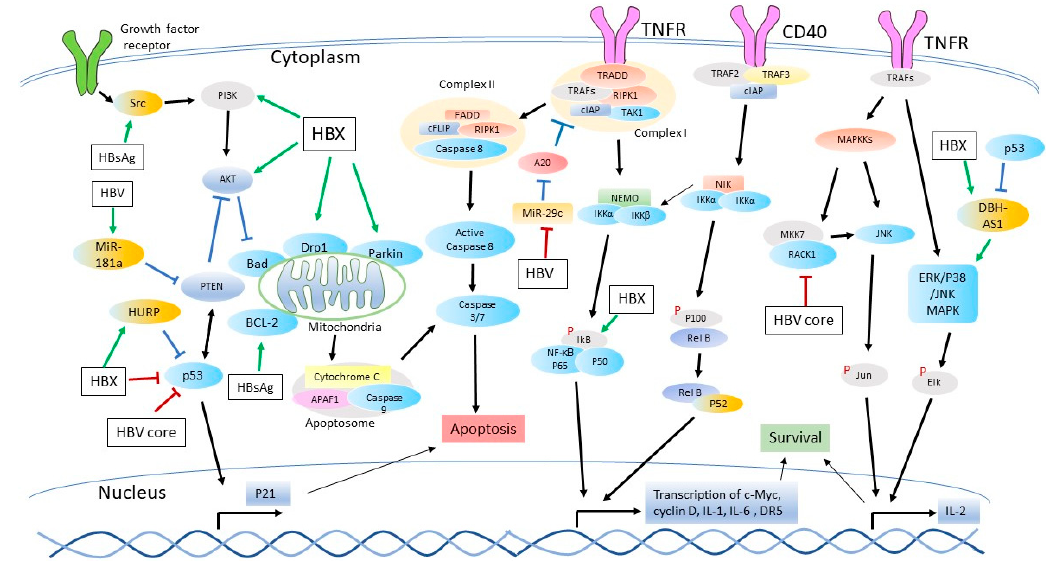
Figure 1. Inhibition of apoptosis by hepatitis B Virus (HBV) infection. Hepatitis B Virus X protein (HBX) and HBV core inhibit p53-mediated apoptosis. HBX activates the phosphatidylinositol-4,5-bisphosphate 3-kinase-protein kinase B (PI3K-Akt) pathway to inhibit apoptosis via the upregulation of PI3K and the induction of Akt phosphorylation. HBX inhibits the intrinsic apoptotic pathway by recruitment of Drp-1 and Parkin to the mitochondria for mitochondrial fission and mitophagy. The activation of Akt also prevents translocation of BAD to the mitochondria, thereby preventing apoptosis. HBX can activate the nuclear factor kappa-light-chain-enhancer of activated B cells (NF- κ B) signaling via the degradation of I κ B. In the MAPK-JNK pathway, HBV can attenuate the function of the kinase that activates JNK. HBV can downregulate apoptosis by either elevation of anti-apoptotic ncRNAs such as MiR-181a, or decrease of pro-apoptotic ncRNAs, such as MiR-29c. Green arrows next to the white boxes (HBV or HBV proteins) denote the activation of apoptosis. Red bars to the white boxes stand for the inhibition of apoptosis. Drp-1: Dynamin-1-like protein. BAD: BCL-2-associated death promoter. MAPK: MAP kinase. JNK: c-Jun N-terminal kinases. ncRNA: Non-coding RNA. MiR-181a/29c: MicroRNA 181a/29c.